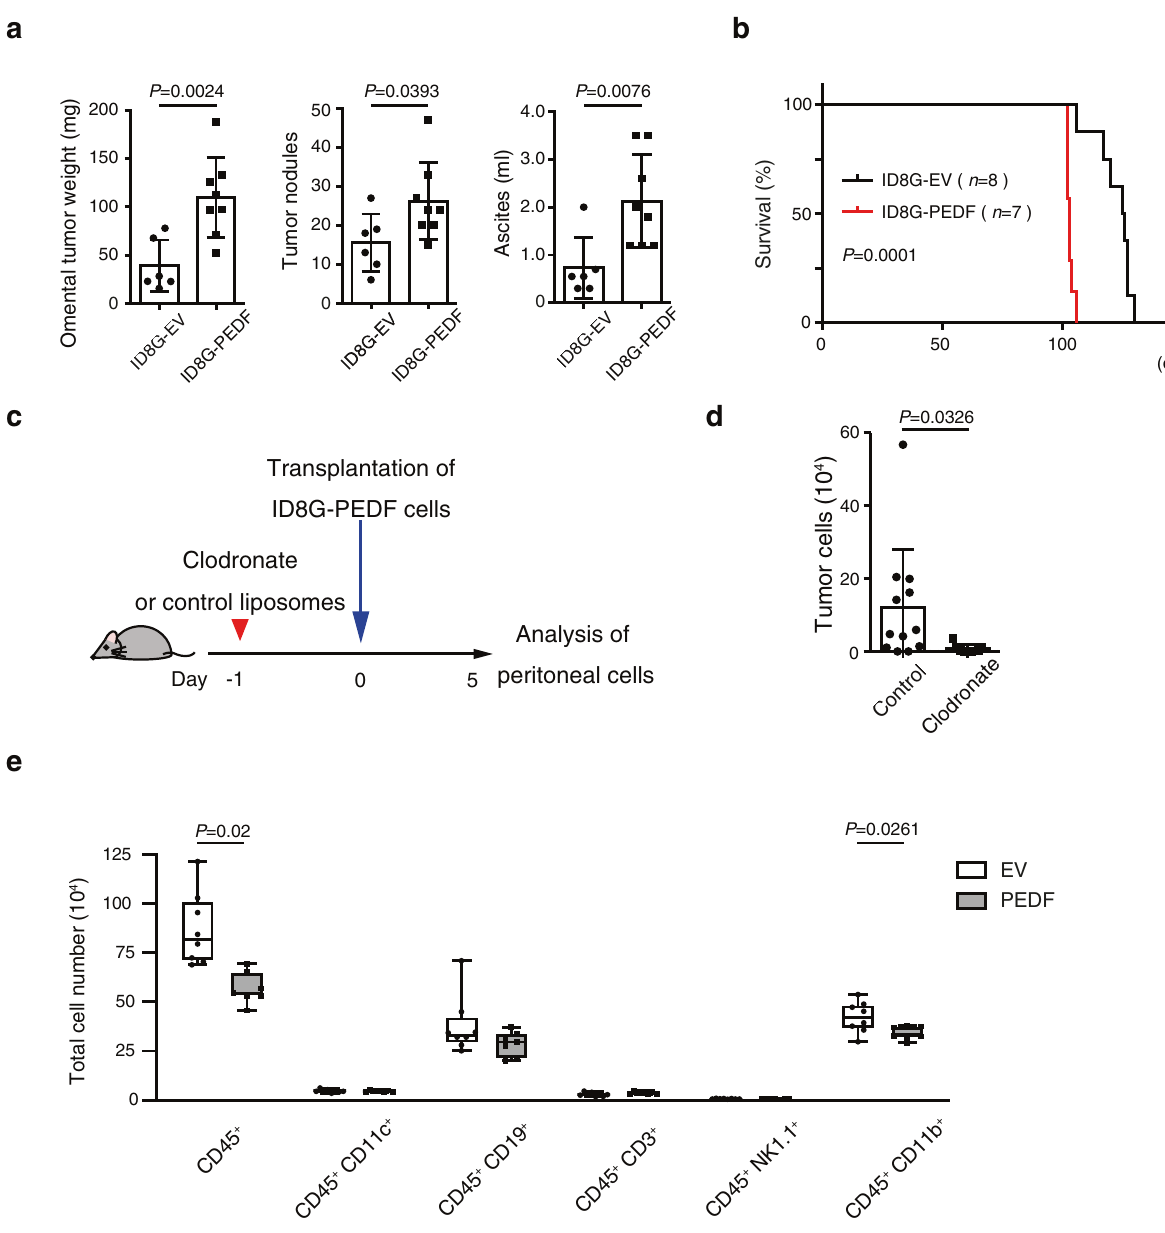
Fig. 4 Macrophages play a critical role in OC cell survival in the peritoneal cavity. a Omental tumor weight, the number of tumor nodules, and the volume of ascites fl uid at 64 days after injection of ID8G-EV ( n = 6 mice) or ID8G-PEDF ( n = 8 mice) cells into the peritoneal cavity of BALB/c-nu/nu mice. Data are means ± SD. b Survival curves for BALB/c-nu/nu mice injected with ID8G-EV ( n = 8) or ID8G-PEDF ( n = 7) cells. The P value was determined with the log-rank test. c C57BL/6 J mice were injected i.v. with control or clodronate liposomes 1 day before injection of ID8G-PEDF cells into the peritoneal cavity. d Flow cytometric analysis of the numbers of GFP + tumor cells in the peritoneal cavity of mice at 5 days after injection of ID8G-PEDF cells in mice treated as in c . Data are means ± SD ( n = 12 or 9 mice for control and clodronate liposomes, respectively). e Flow cytometry quanti fi ed CD45 + cells, CD45 + CD11c + dendritic cells, CD45 + CD19 + B cells, CD45 + CD3 + T cells, CD45 + CD3 − NK1.1 + NK cells, and CD45 + CD11b + myeloid cells in the peritoneal cavity, 5 days after i.p. injection with ID8G-EV ( n = 8) or ID8G-PEDF cells ( n = 7) into C57BL/6 J mice. Data are presented as box-and-whisker plots. Data for a , d , e were analyzed by unpaired t test with Welch ’ s